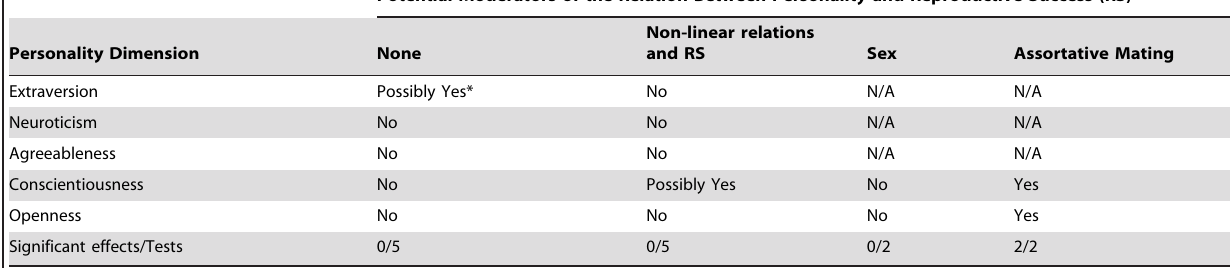
Table 3. Support for Different Results by